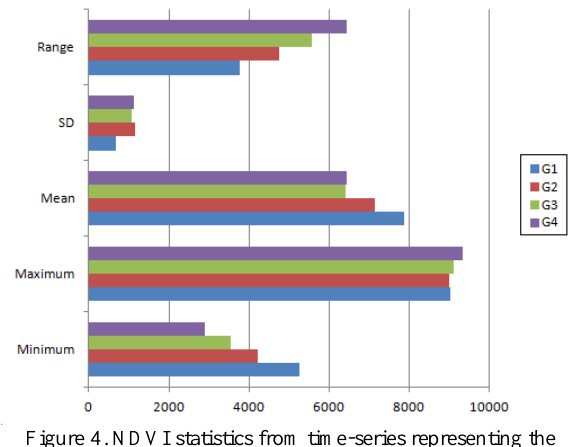
Figure 4. NDVI statistics from time-series representing the mean values for each group with different textural compositions, based on the amount of fine-grained